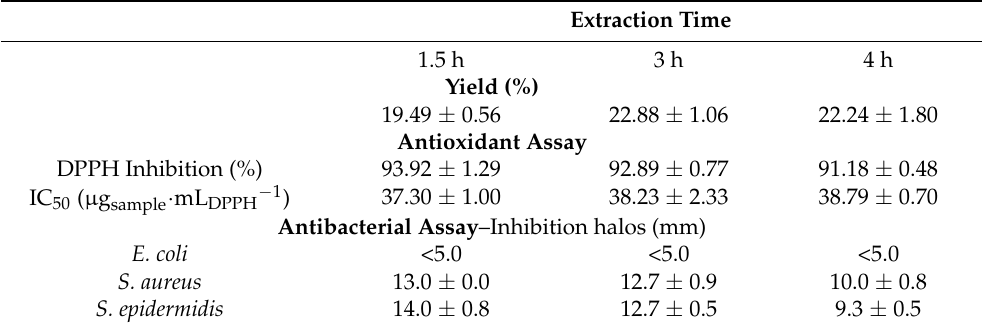
Table 1. Extraction yield, antioxidant, and antimicrobial capacity results for each extraction